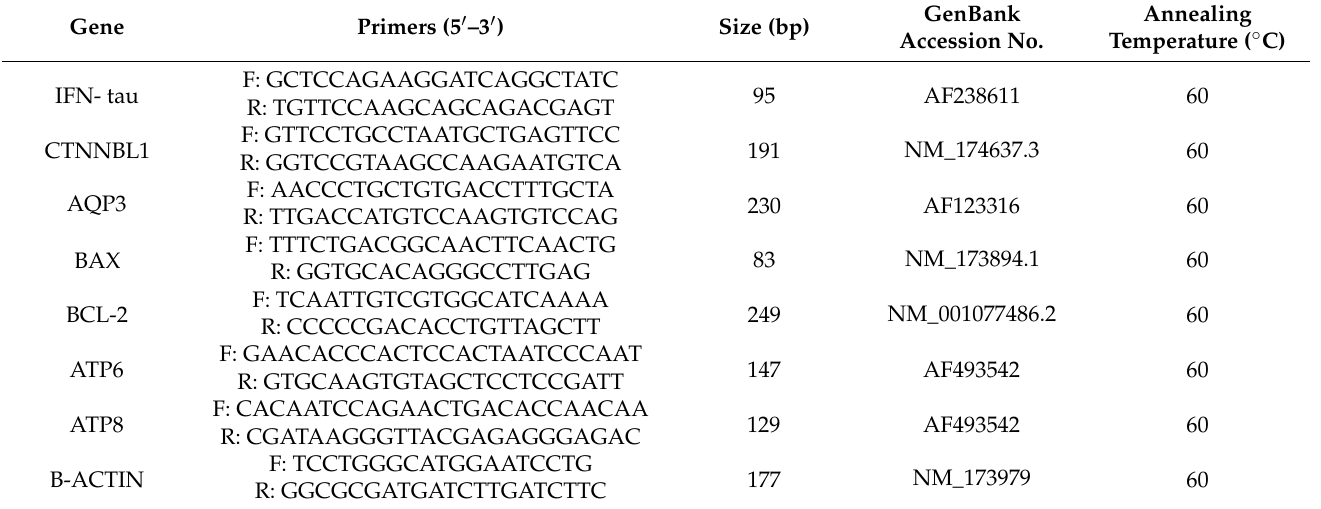
Table 1. Primers used for qRT-PCR of candidate genes in oocytes and